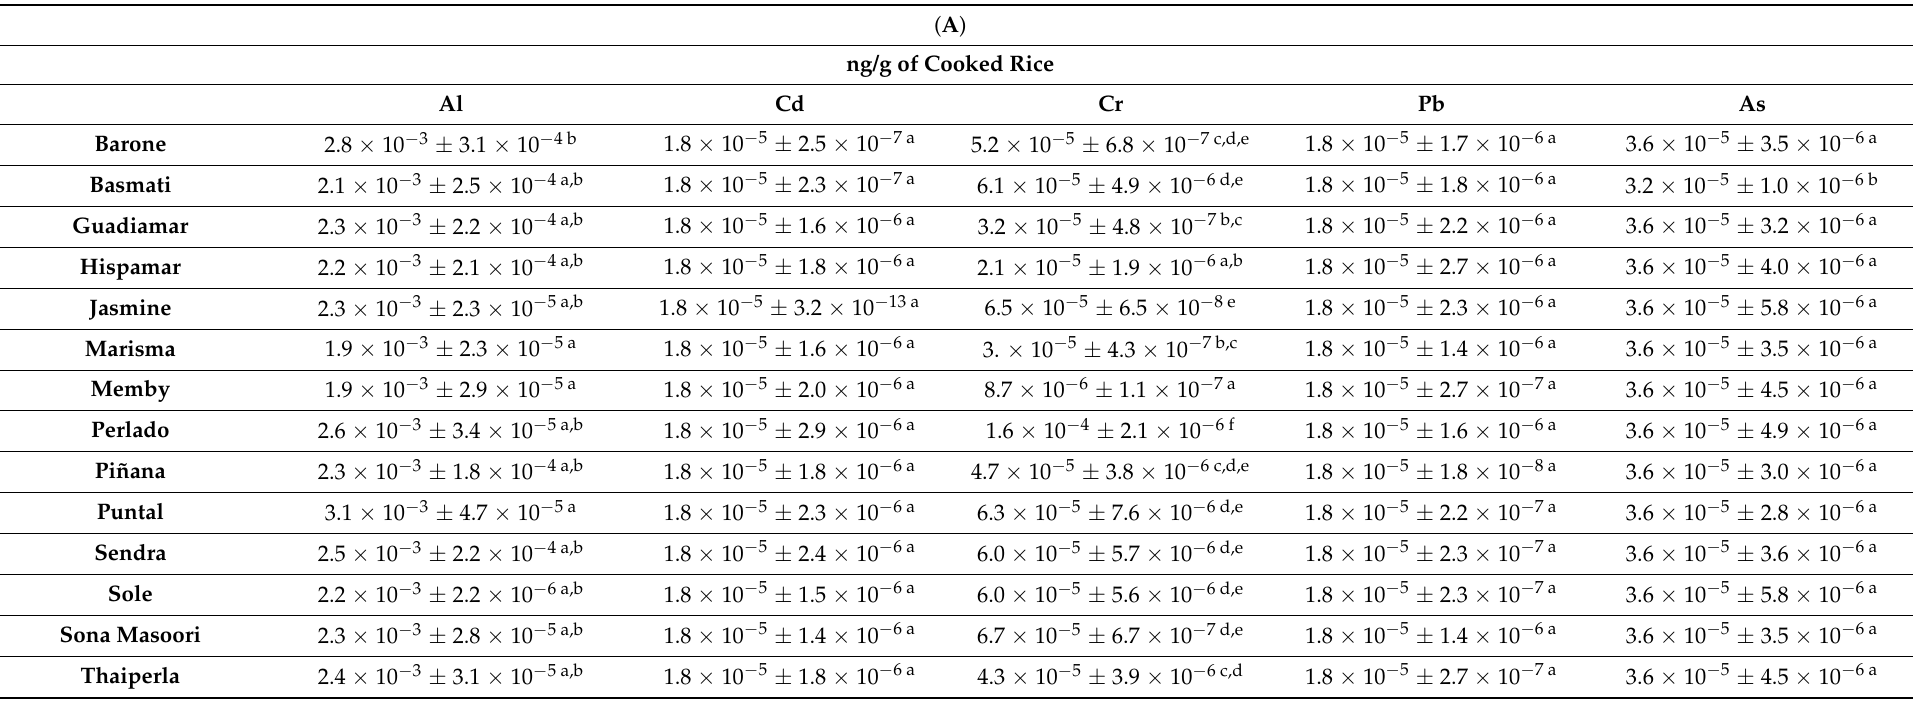
Table 9. ( A ). Metallic and metalloid elements values in cooked rice; ( B ). Metallic and metalloid elements values in the digestible fraction of